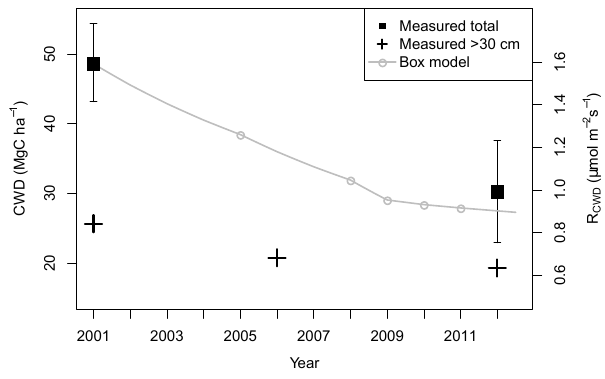
Figure 3. Measurements of total CWD (black squares with 95% bootstrapped CI error bars) and subsets of CWD ≥ 30cm diam- eter (black crosses) show a decrease over time. CWD box model (gray line) also shows a gradual decrease in CWD over time. The initial condition is the 2001 measurement of CWD; the source is input from mortality inferred by biometry census (census times rep- resented by gray circles), and the sink is an empirical respiration rate of 0.124yr − 1 (Pyle et al., 2008). Left axis shows the CWD res- piration flux ( R CWD ), corresponding to the equivalent amount of CWD on the right